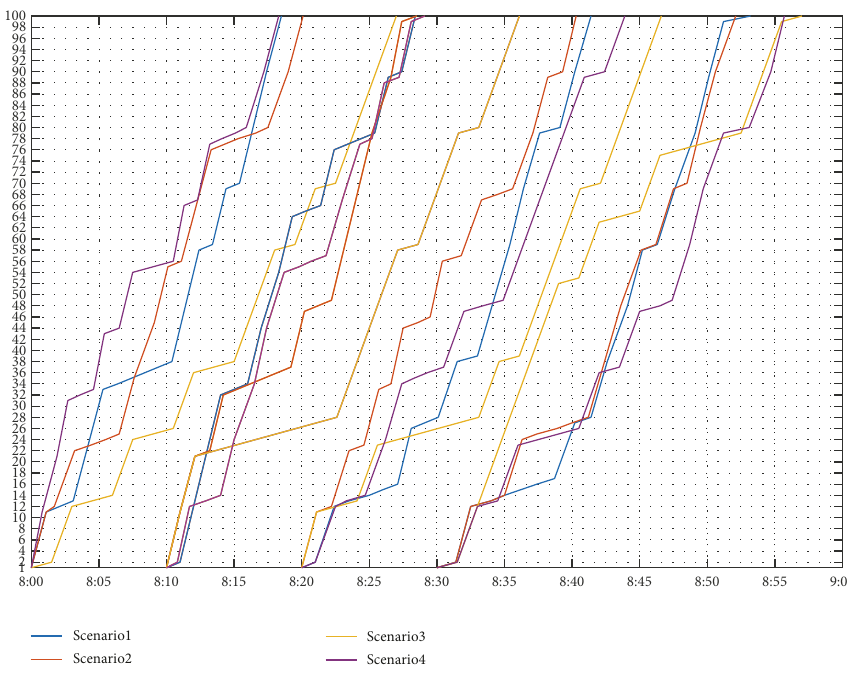
Figure 11: The shortest routes under four scenarios from node 1 to node 100 at different departure times. Table 7: The shortest routes from node 1 to node 100 at different departure time (in Scenario 2).